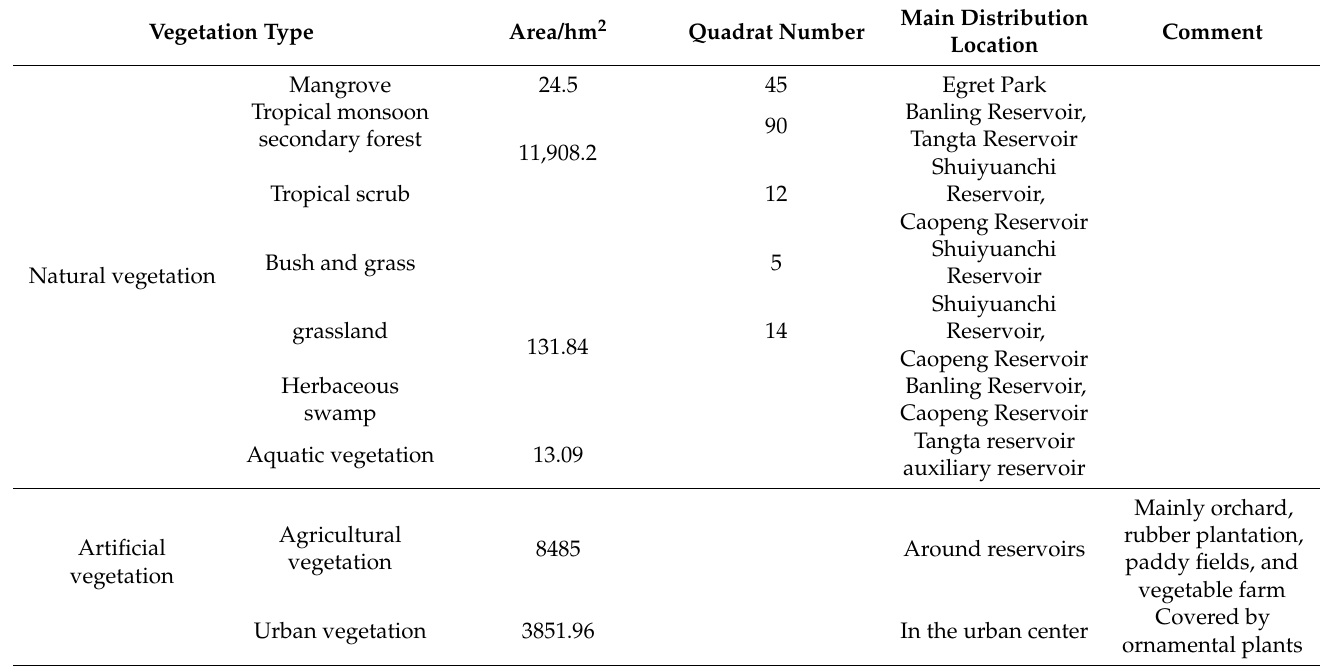
Figure 2. Distribution of samples in the Sanya River Basin, Hainan Province, China; represent- ing the quadrat containing rare and endangered plants; representing the quadrat without rare and endangered plants. ( A ): Sample plot distribution map of Tangta Reservoir; ( B ): Sample plot distribution map of Shuiyuanchi Reservoir; ( C ): Sample plot distribution map of Caopeng Reservoir; ( D ): Sample plot distribution map of Banling Reservoir with the second richest species and the largest species number of rare and endangered plants; ( E ): Distribution map of sample plots of six parks in the city center, mainly mangroves. Table 2. Vegetation types and their coverage area in Sanya River Basin, Hainan Province, China. It can be divided into natural vegetation and artificial vegetation. The area of the reservoir is much larger than that of mangroves, and more plants can survive.